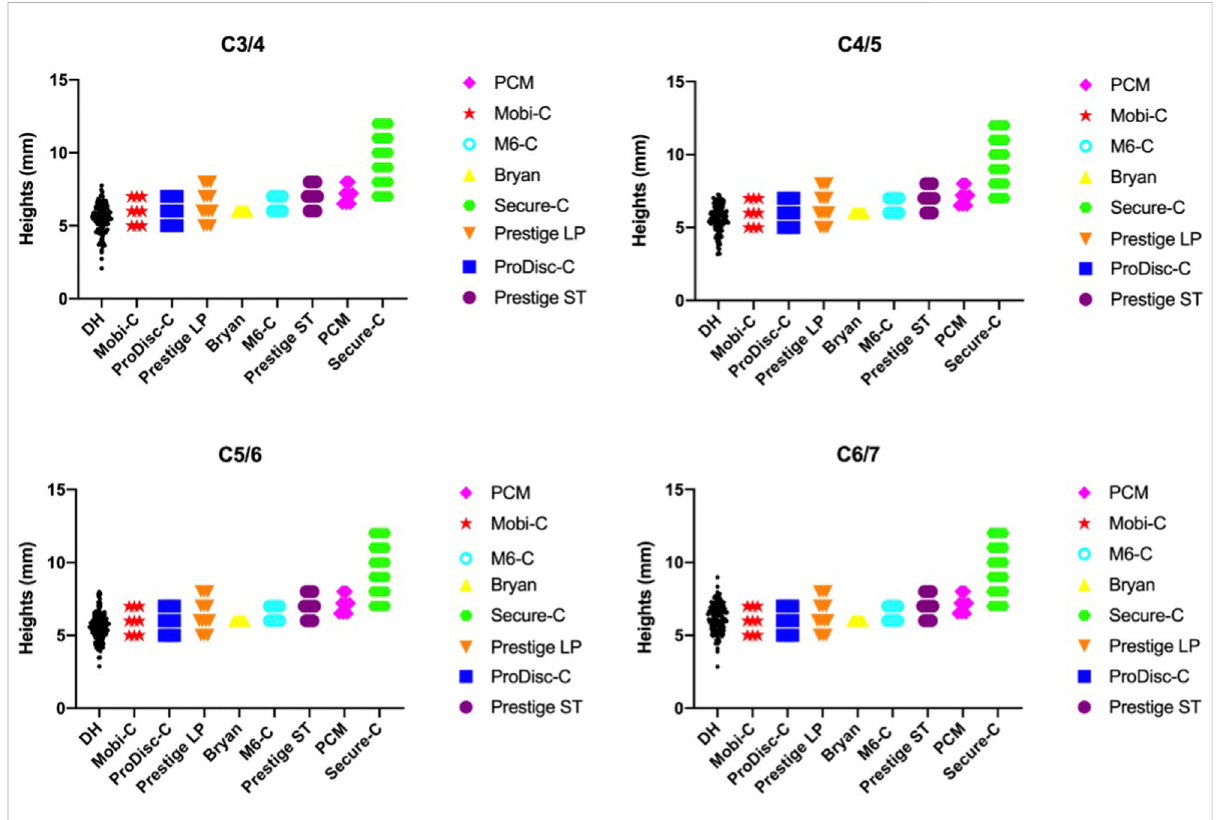
FIGURE 7 Mismatch between cervical anatomical data and the sizes of